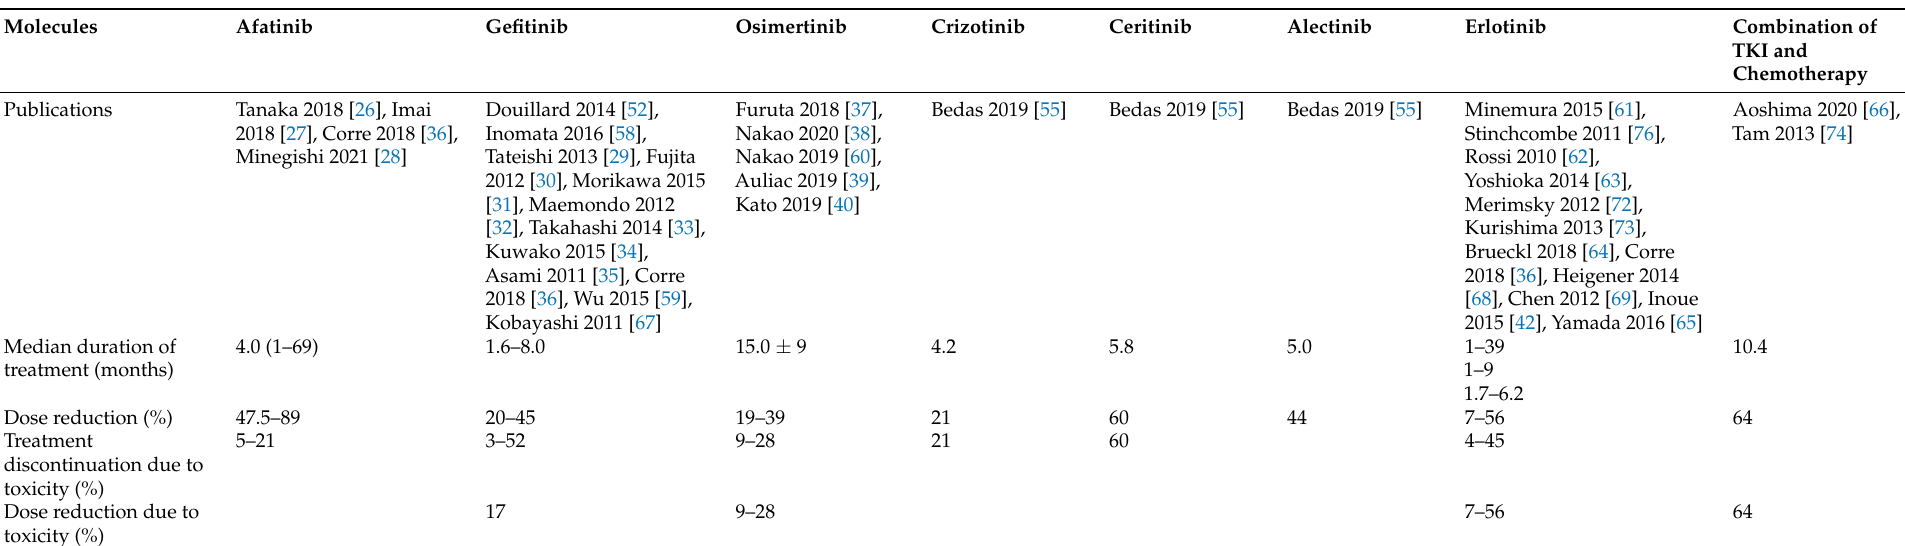
Table 6. Targeted therapy feasibility results in older patients in non-randomized